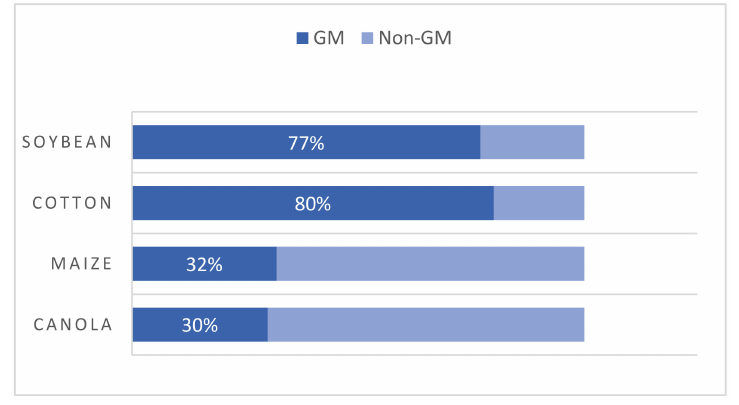
Figure 1. Percentages of the main biotech crops in 2017. Adapted from